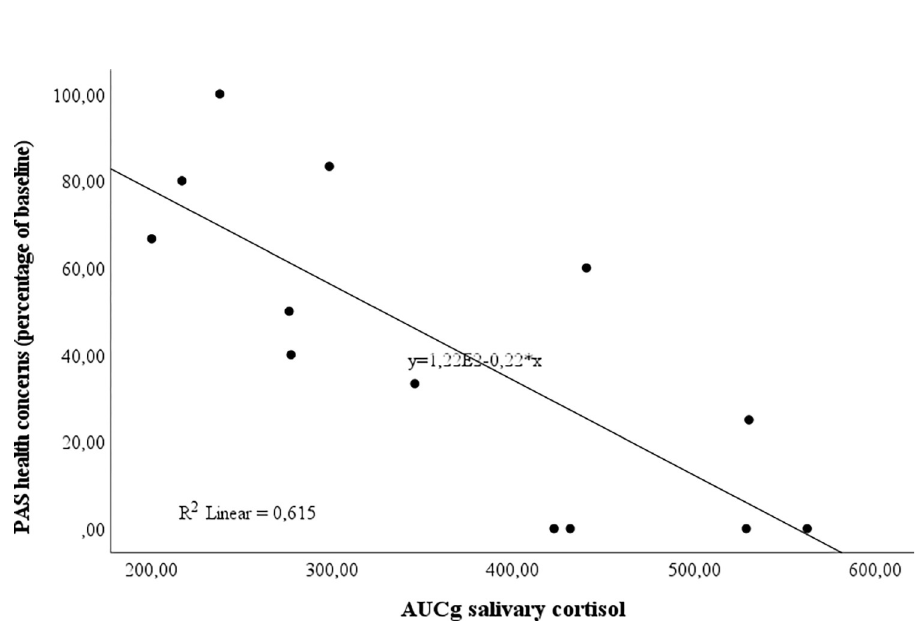
Fig 5. Correlation between salivary cortisol (AUCg) and the PAS subscale health concerns. The lower the cortisol response under Low Intensity Exercise (LIE), the lower the improvement (higher percentage of baseline) in PAS health concerns under intensive cognitive-behavioral therapy. Abbreviations / S3 File: AUCg, Area under the Curve with respect to ground; LIE, low intensity exercise; PAS, Panic and Agoraphobia Scale.